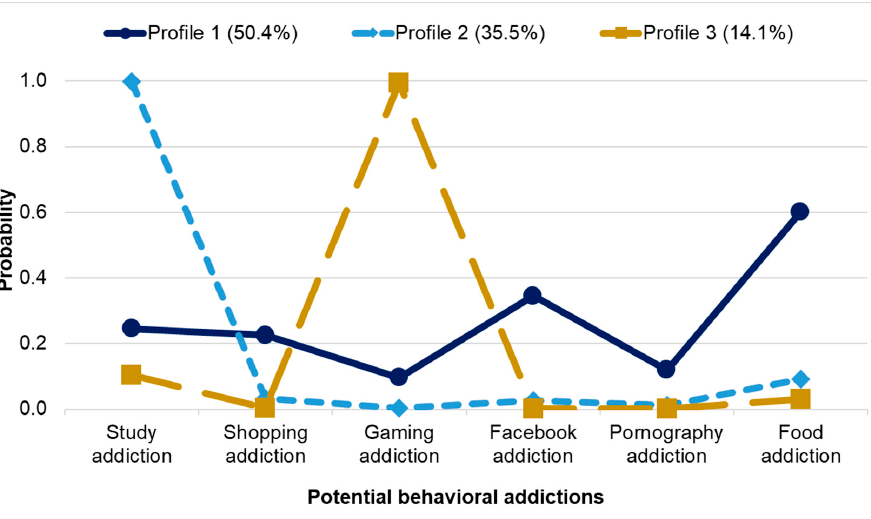
Figure 3. Three-Class LCA Model Results. N = 327. Table 8. Potential Predictors and Outcomes of LCA Membership: Comparison of